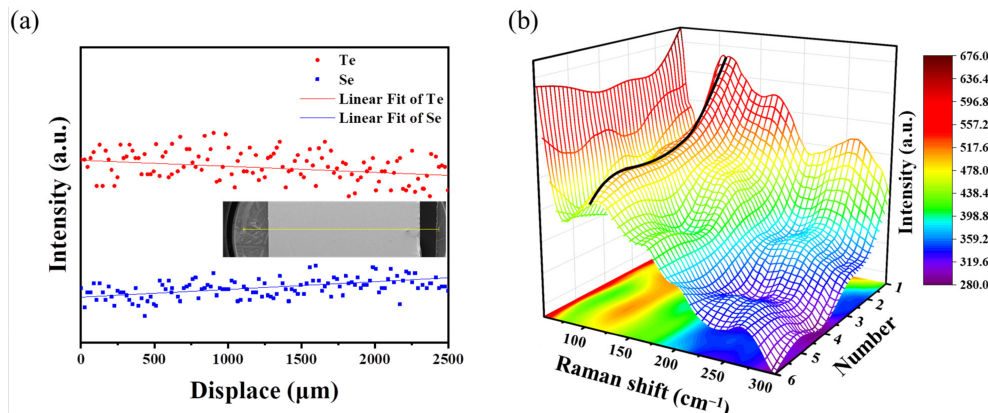
Figure 6. ( a ) EDS line scanning results of the GRIN lenses. The inset is the line scan direction; ( b ) Raman line scanning spectra of the GRIN lenses; numbers 1–6 in the figure represent the positions of the GRIN lens from top to bottom, and the color scale represents the intensity of the Raman